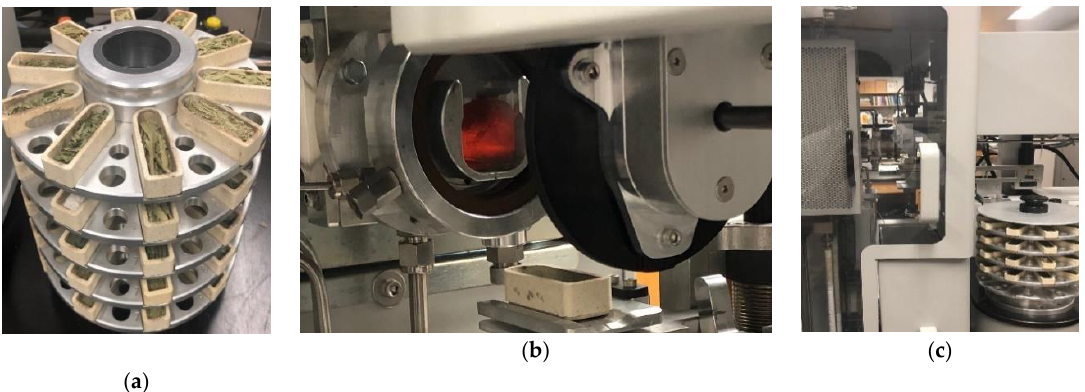
Figure 4. Actual N content measurement using an LECO TruMac N analyzer system (LECO Corporation, St. Joseph, MI, USA). Samples placed in the ( a ) stacked tray were collected automatically by a ( b ) combustion zone. ( c ) Overall set-up.